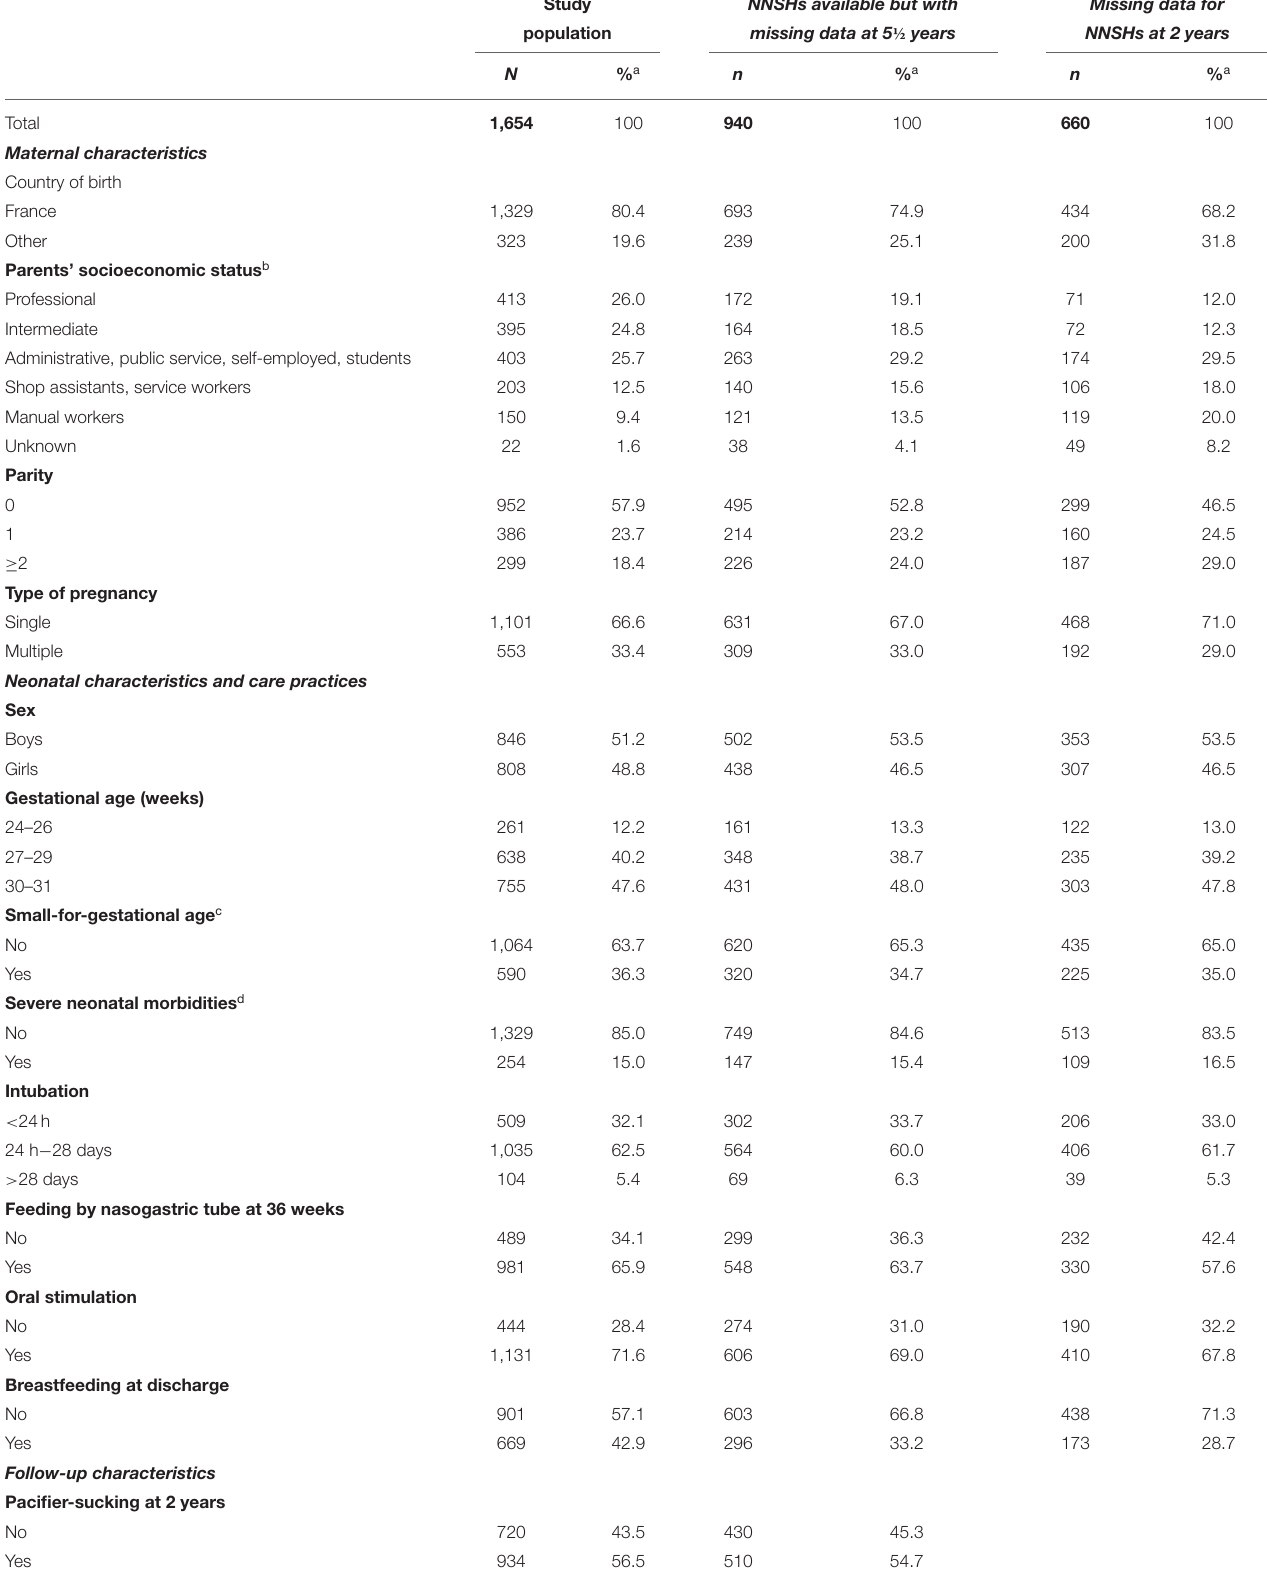
TABLE 1 | Maternal, neonatal, and follow-up characteristics of the study population and those with missing data. Study NNSHs available but with Missing data for population missing data at 5 ½ years NNSHs at 2